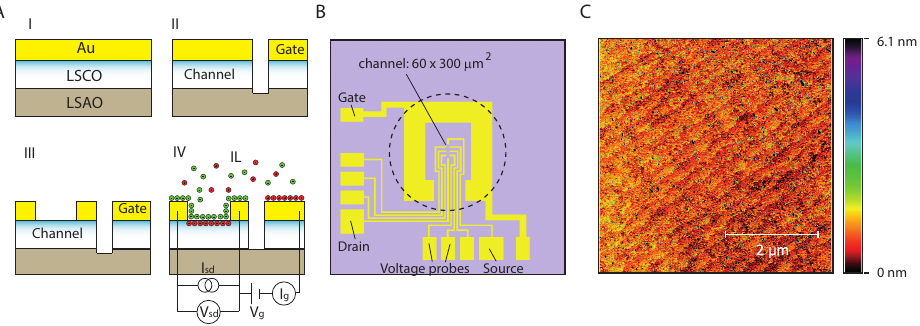
Figure 6. ( A ) Schematics of the sample preparation. ( I ) After in-situ pulsed laser deposition of 10 to 30 UC of La Sr CuO (LSCO) on a LaSrAlO (LSAO) substrate, followed by Au deposition; 2 − x x 4 4 ( II ) After dry etching of the areas defined by photolithography; ( III ) After wet etching of the excess Au between the source and drain electrodes using a KI/I /H O solution; ( IV ) Schematic representation 2 2 of the electronic circuit of the IL/La Sr CuO system; ( B ) Layout of the electrodes and the channel 2 − x x 4 (60 × 300 µ m 2 ). All yellow colored structures are Au covered, while at nearly all of the violet areas the dry etching process has exposed the substrate, except in the center of the structure between the contacts, where the LSCO channel is uncovered by the wet etching step in KI/I . The dashed circle 2 represents the approximate area covered by the IL droplet at the sample surface; ( C ) An example of an AFM image of the surface of the La Sr CuO channel (10 UC) after fabrication, before adding the IL. 2 − x x 4 The film rms roughness is 0.49 nm, and clear steps of the film are